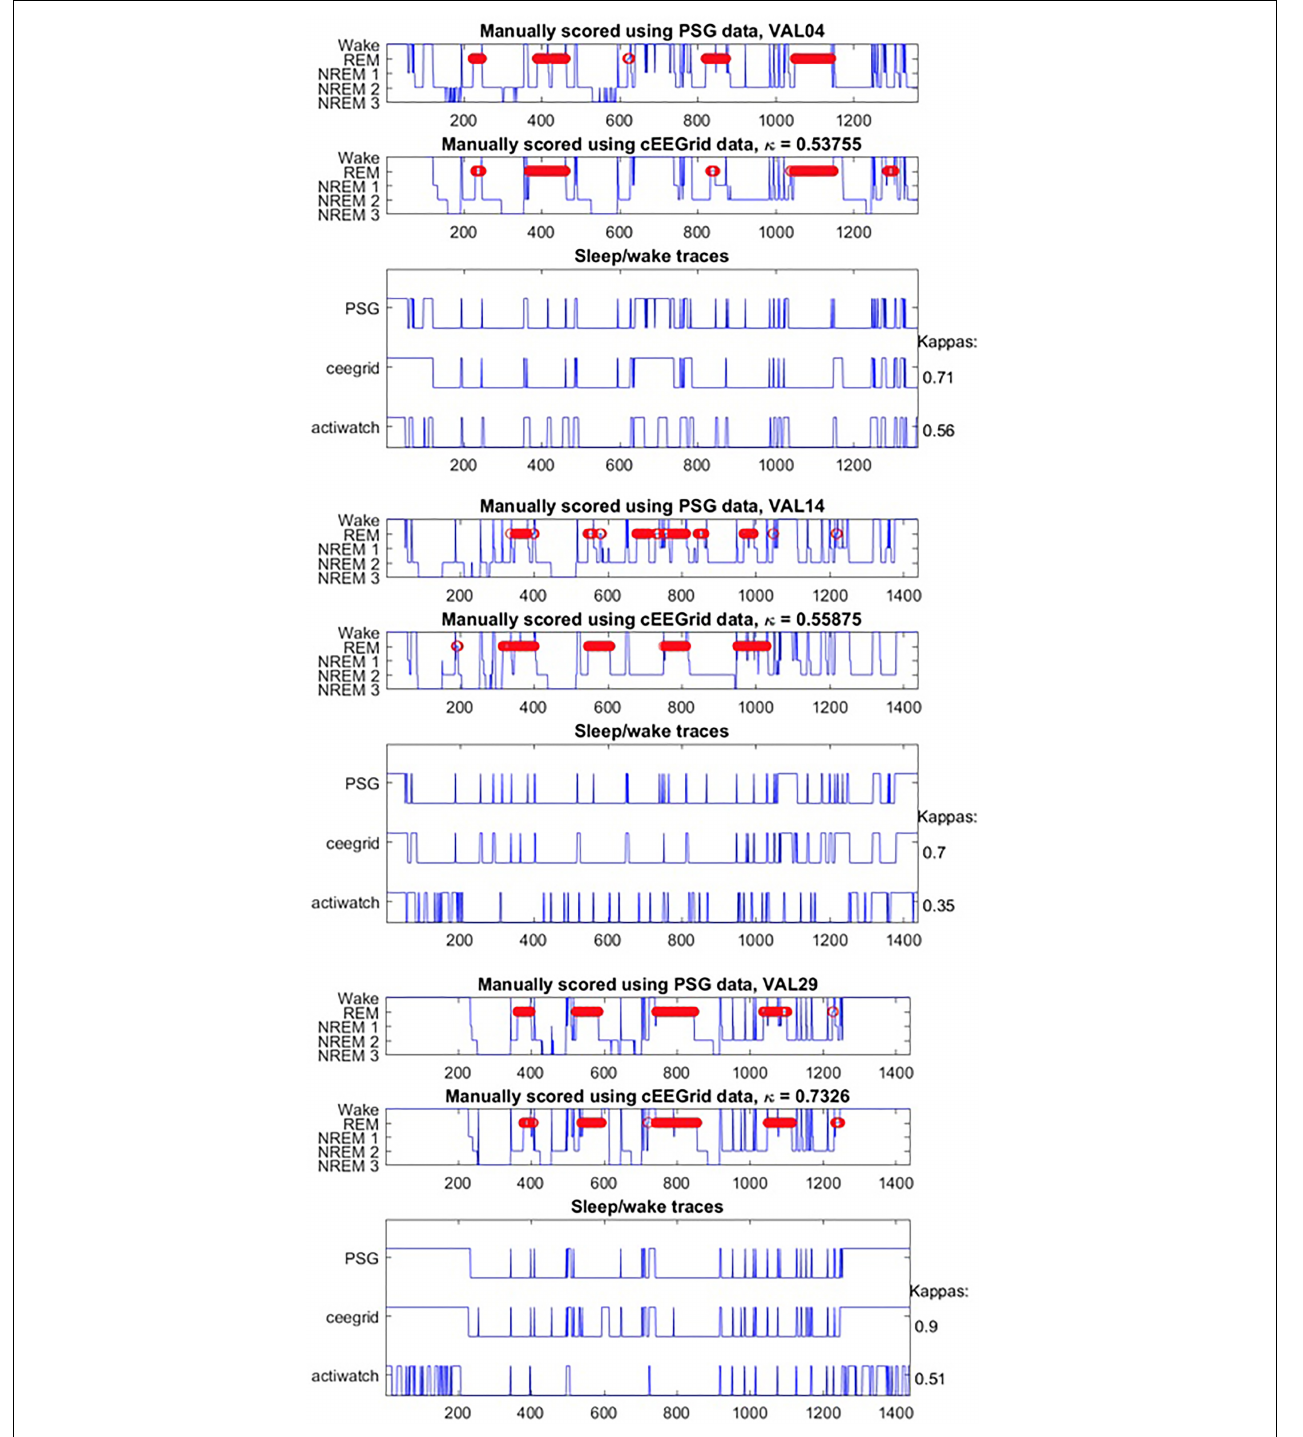
FIGURE 3 | Hypnograms from three